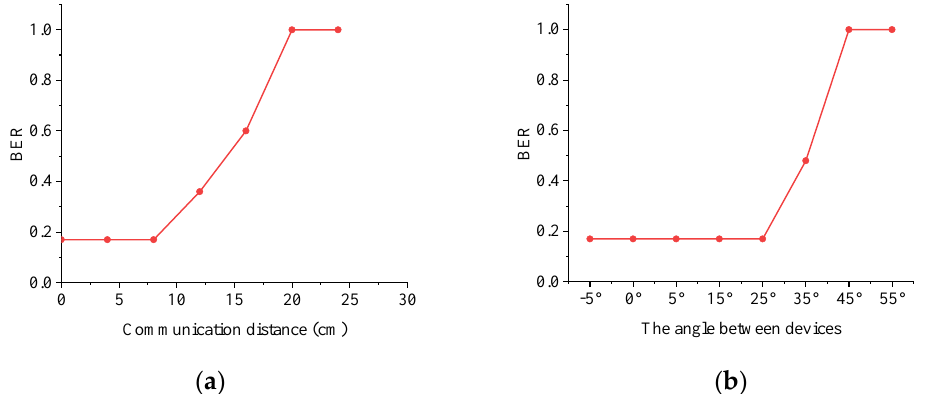
Figure 10. ( a ) BER under different distances in downlink. ( b ) BER under different angles in downlink.